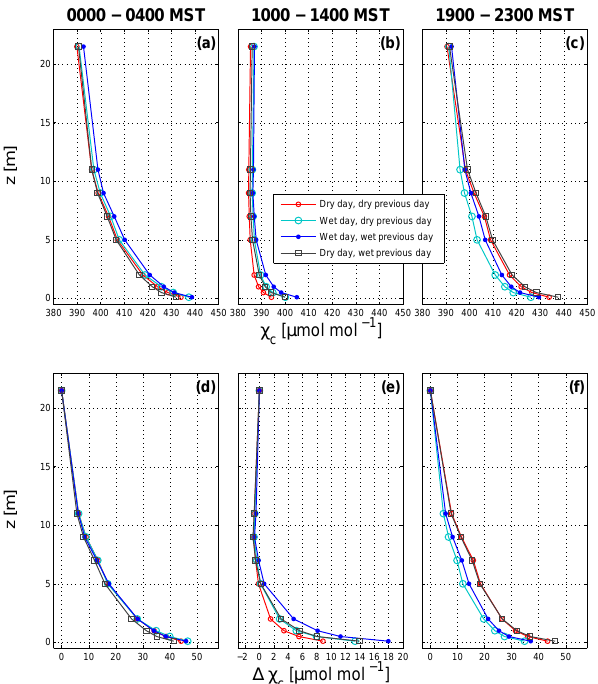
Figure 8. Mean vertical profiles of CO 2 mole fraction χ c for (left) nighttime (00:00–04:00MST), (middle) mid-day (10:00– 14:00MST), and (right) late evening (19:00–23:00MST). The up- per row is absolute χ c while the bottom row is the χ c difference relative to the highest level (21.5m). Each line represents a differ- ent precipitation state as shown in the legend. These measurements are from the warm season in years